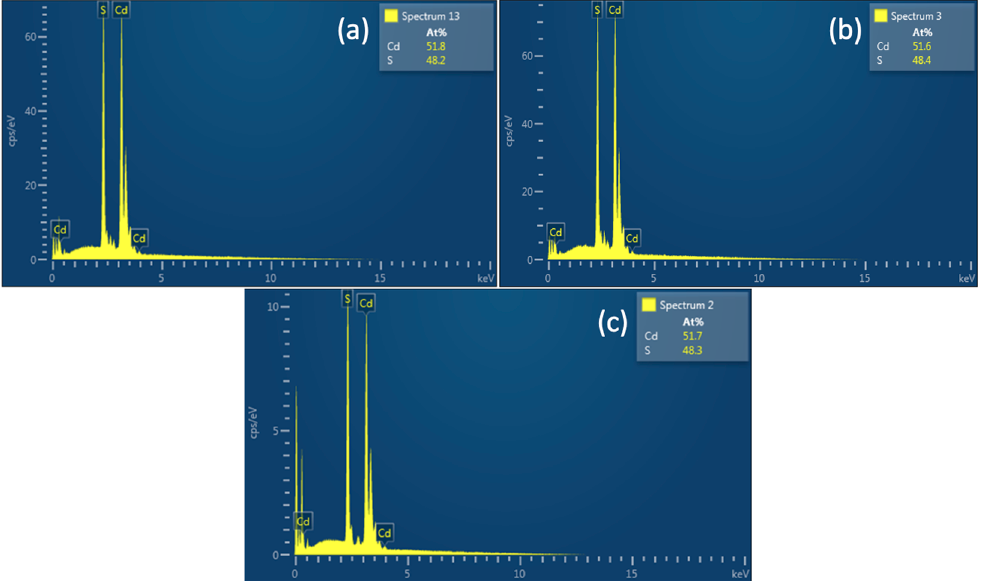
Figure 3. ( a ) EDS of CdS-HT; ( b ) EDS of CdS-HTa400; ( c ) commercial CdS.